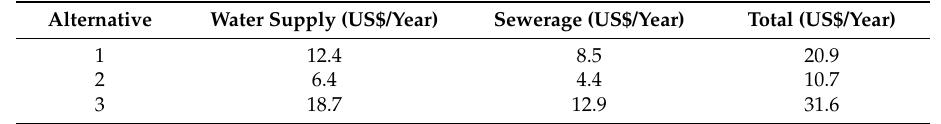
Table 5. Annual monetary savings on water supply and sewage bills for the three proposed systems.